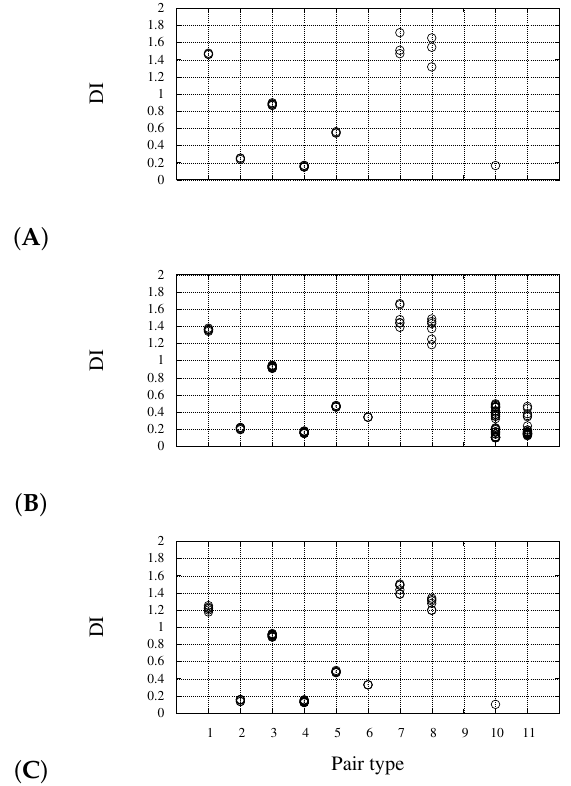
Figure 5. DI ( y axis) for different atom pairs (see list below and Figure 2) for the isolated monomer ( A ) and for the dimer ( B ), both with total charge q = − 2. Panel ( C ) is with the addition of Mg far from molecule (total charge zero). List of atom pairs: 1—Pt1-Ct; 2—Pt1-Ot; 3—Pt1-Cb; 4—Pt1-Ob; 5—Pt1-Pt1; 6—Pt1-Pt16; 7—Ct-Ot; 8—Cb-Ob; 10—different from above, but intra-monomer;